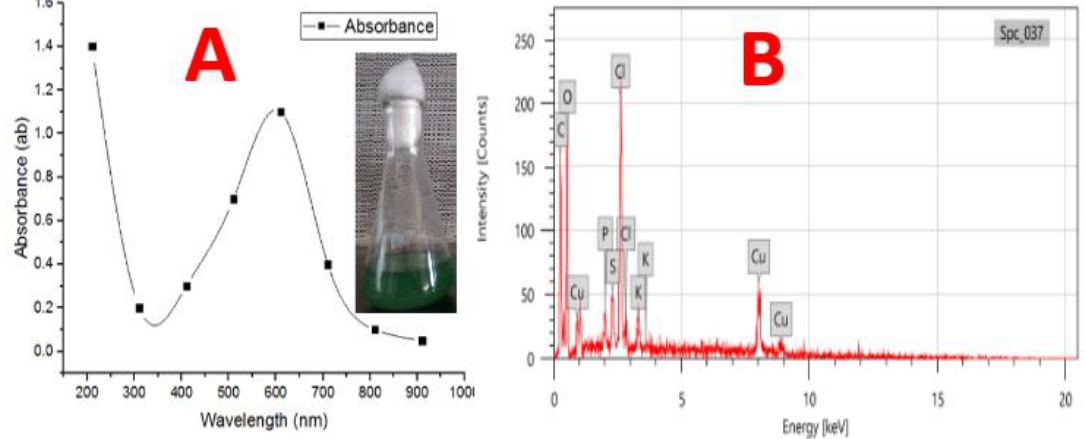
Figure 6. ( A ) UV–Vis spectrum of CuNPs. ( B ) Energy-dispersive X-ray spectroscopy (EDX) analyzer image of biotransformation of CuNPs by P. fluorescens MAL2.